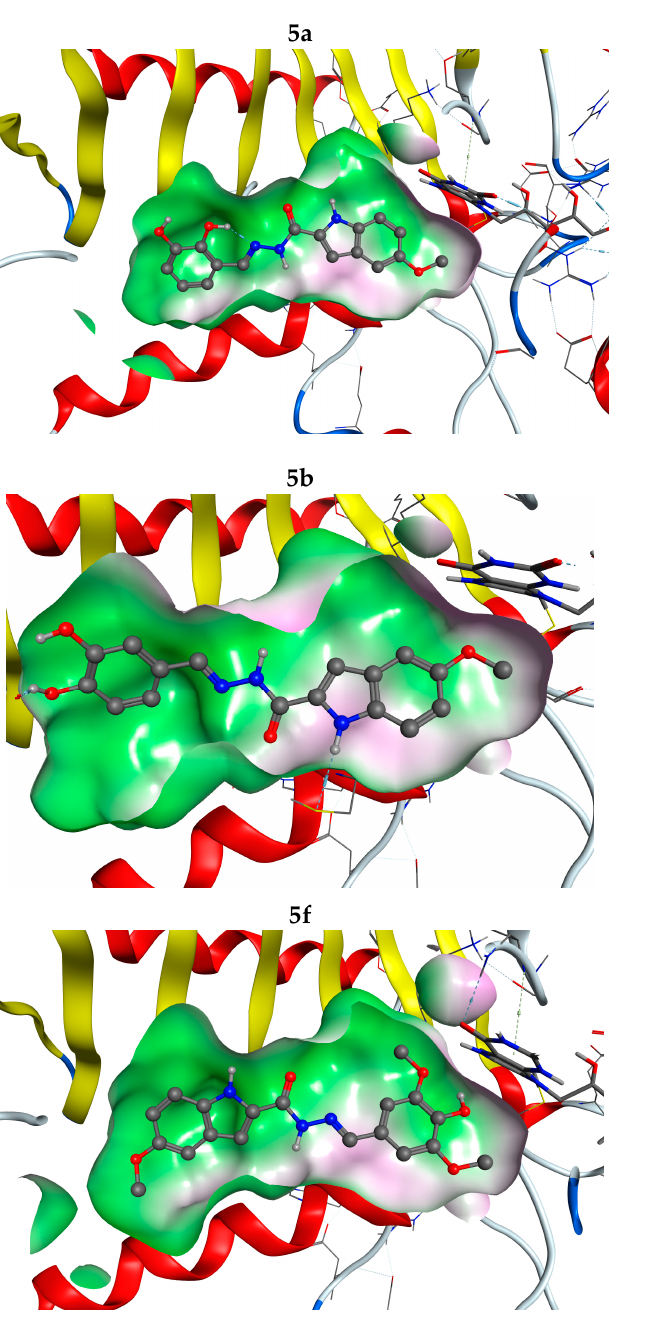
Figure 10. Docking poses of selected ligands in the MAO-B cavity (left part) and schematic representation of the neighboring amino acid residues and interactions (right part); the components and interactions are described by the following color patterns: proximity contour—black dotted line; polar amino acids—pink; lipophilic amino acids—green; basic amino acids—blue; acidic amino acids—red; hydrogen bond interactions—blue arrows; lipophilic interactions—green dotted lines; docked structures—represented by balls and sticks; and FAD—represented by sticks.